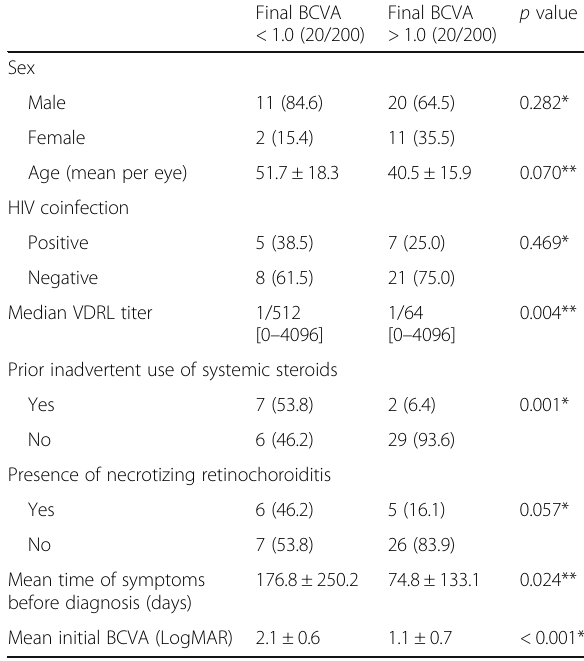
Table 2 Prognostic factors associated with syphilitic posterior uveitis in 44